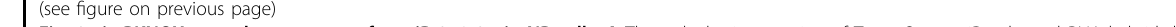
Fig. 3 circPKNOX1 acted as a sponge for miR-370-3p in NP cells. A Through the intersection of TargetScan, miRanda, and RNA hybrid data, circPKNOX1 target microRNA was predicted. B After knocking down circPKNOX1, the expression level of hsa-miR-370-3p increased; * P <0.05. Data represent mean±SD, and the P values were determined by a two-tailed unpaired Student ’ s t test. C The expression level of miR-370-3p increased in degenerated tissues (six different donors); * P <0.05. Data represent mean±SD, and the P values were determined by a two-tailed unpaired Student ’ s t test. D Left: the fl uorescence intensity of miR-370-3p increased in degenerated tissues, as determined using fl uorescence in situ hybridization (scale bar, 25 – 100 μ m). Right: the fl uorescence intensity was quantitatively analyzed (two different donors); *** P <0.01. Data represent mean±SD, and the P values were determined by a two-tailed unpaired Student ’ s t test. The miR-370-3p probe was labeled with Alexa Fluor 488. E miR-370-3p was located in the cytoplasm and intersected with circPKNOX1 in the cell substructure (scale bar, 25 μ m). F The binding site of circPKNOX1 and miR-370- 3p was identi fi ed using CircInteractome. G The ef fi ciency of miR-370-3p mimic and inhibitor was detected; * P <0.05. Data represent mean±SD, and the P values were determined by a two-tailed unpaired Student ’ s t test. H The expression of related proteins (collagen II, aggrecan, SOX9, MMP3, MMP13, ADAMTS4, and ADAMTS-5) was detected using western blotting. I The fl uorescence intensity of related proteins (collagen II, aggrecan, ADAMTS4, and MMP13) was detected via an immuno fl uorescence assay (scale bar, 100 μ m). J RT-qPCR was used to detect the expression of related genes; * P <0.05, ** P <0.01, *** P <0.001. Data represent mean±SD, and the P values were determined by a two-tailed unpaired Student ’ s t test. K Left: the extracellular matrix was detected by Alcian staining. Right: the Alcian staining was quantitatively analyzed. Data represent mean±SD, and the P values were determined by a two-tailed unpaired Student ’ s t test.